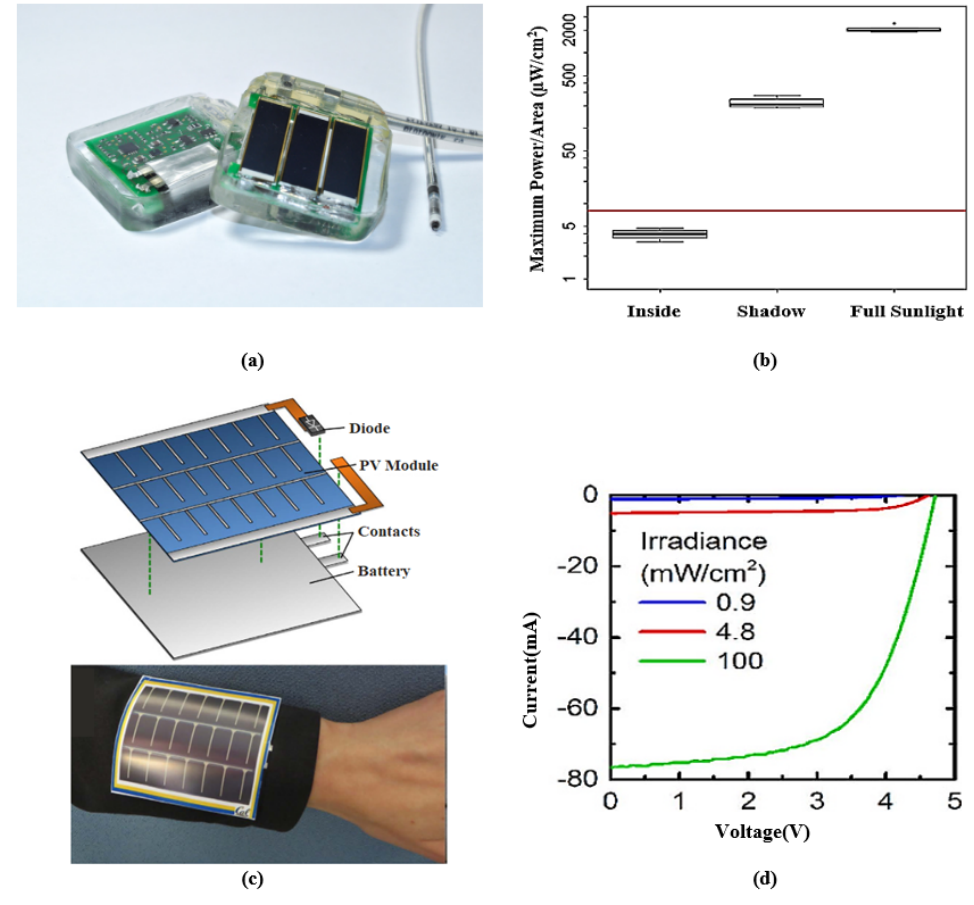
Figure 7. ( a ) A batteryless solar-powered cardiac pacemaker prototype; the rear part is lithium- polymer storage (silver color). ( b ) Boxplot demonstrates the output power at various irradiances. Reprinted from [232]. ( c ) Photovoltaic energy harvesting system with the flexible battery mounted on the curved surface (sleeves). ( d ) I-V characteristics of photovoltaic cell charging the flexible battery. Adapted from